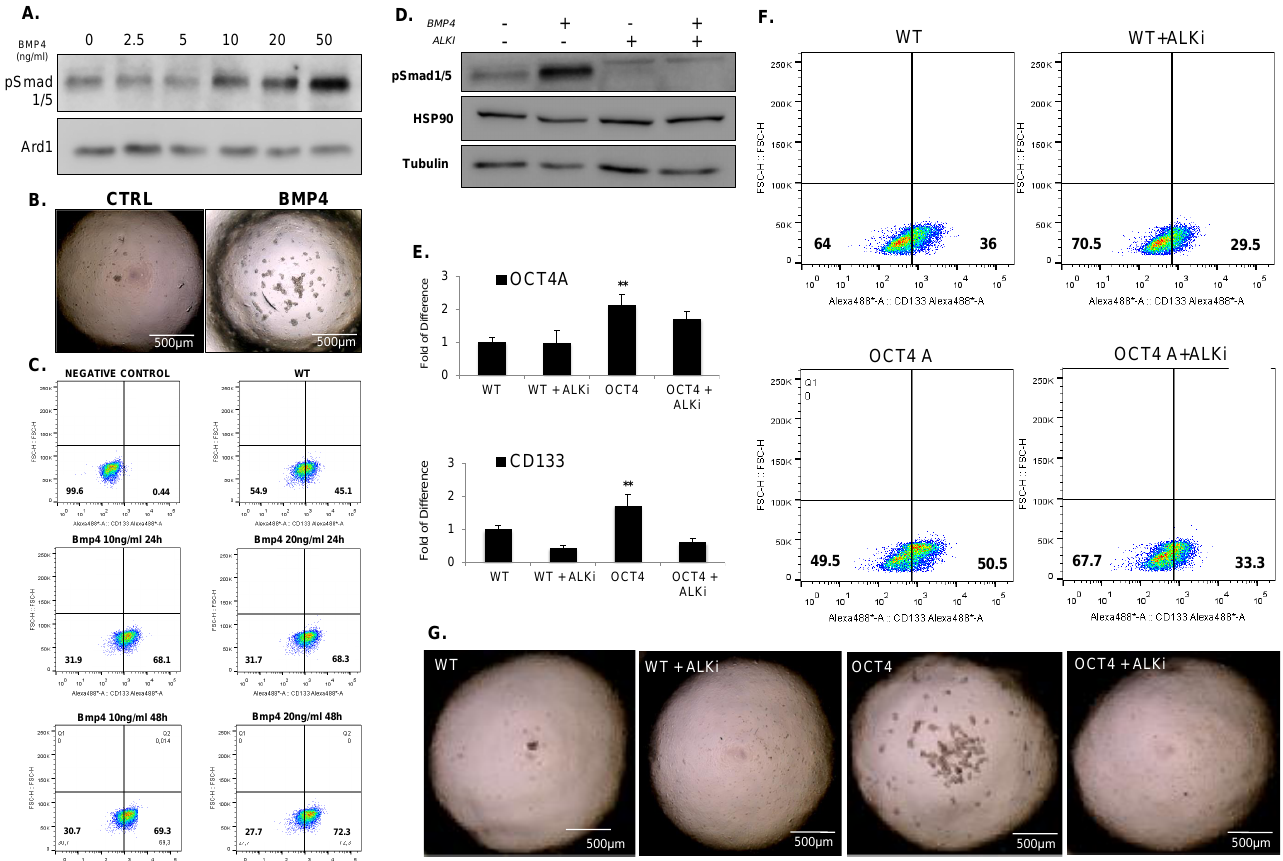
Figure 5. BMP4 signaling promotes TICs and stem cell traits. ( A ) Immunoblot analysis showing the protein level of phosphorylated Smad1/5 in HDMB03 cells exposed to increased dose of BMP4 from 0 to 50 ng/mL. Tubulin was used as a loading control. ( B ) Representative images of tumorsphere(s) generated from HD-MB03 untreated (CTRL) (left panel) and treated with 50 ng/mL of BMP4 (BMP4) (right panel). ( C ) FACS analysis showing the expression of CD133 in HD-MB03 exposed to 10 ng/mL or 20 ng/mL of BMP4 for 24 h or 48 h. ( D ) Immunoblot showing the protein level of phosphorylated Smad1/5 in HD-MB03 cells treated or untreated with 20 ng/mL of BMP4 and ALK2/3 inhibitor (LDN 198836) for 24 h. ( E ) qPCR analysis showing the expression of stem-cell markers OCT4A, and CD133 in parental HDMB03 (WT) and OCT4-expressing HD-MB03 (OCT4) cells treated or untreated with ALK2/3 inhibitor (LDN 198836) for 24 h. ** p < 0.01, according to two-tailed paired Student’s t-test. Data are the mean ± SD. ( F ) FACS analysis for CD133 in parental HD-MB03 (WT) and OCT4- expressing HD-MB03 (OCT4) cells treated or untreated with ALK2/3 inhibitor (LDN 198836) for 24 h. ( G ) Representative images of tumorsphere(s) generated from parental (WT) and OCT4-expressing (OCT4) HD-MB03 cells cultured with or without ALK2/3 inhibitor (LDN 198836). The original blots could be found in the Figure